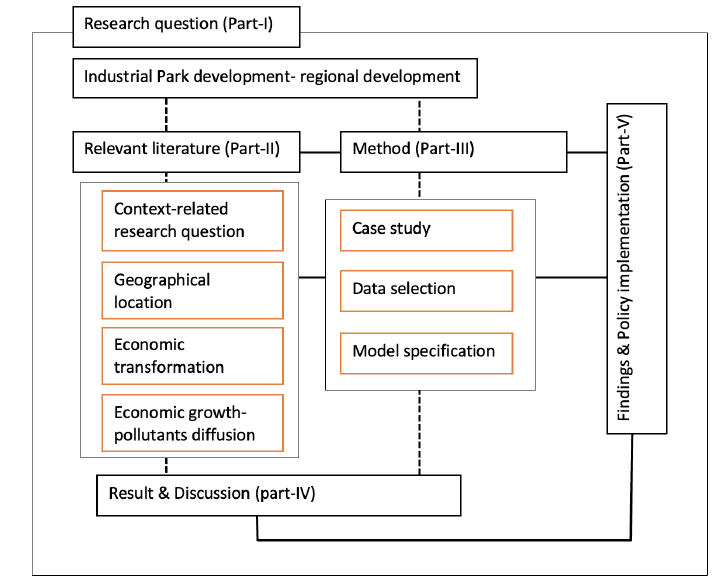
Figure 2. Research